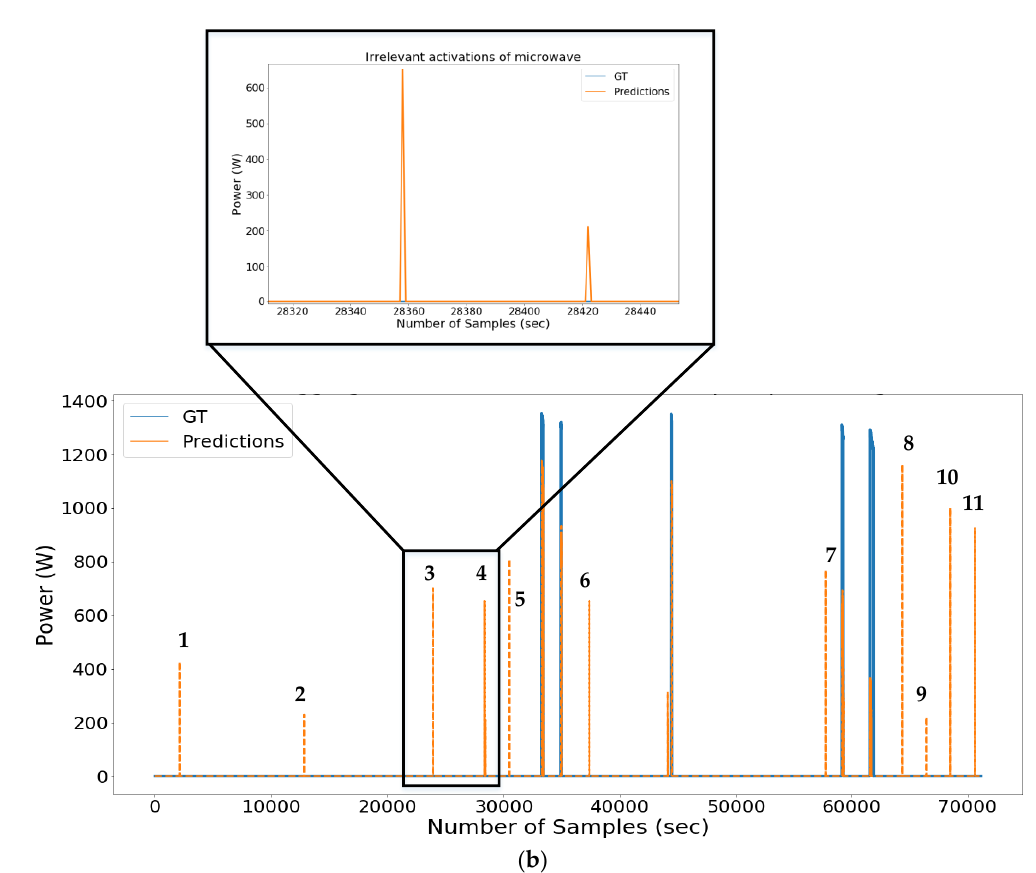
Figure 3. An example of predicted energy sequence of ( a ) dishwasher and ( b ) microwave showing the presence of irrelevant activations with a zoomed-in view of irrelevant activation shape and length that does not correspond to ground-truth activation.